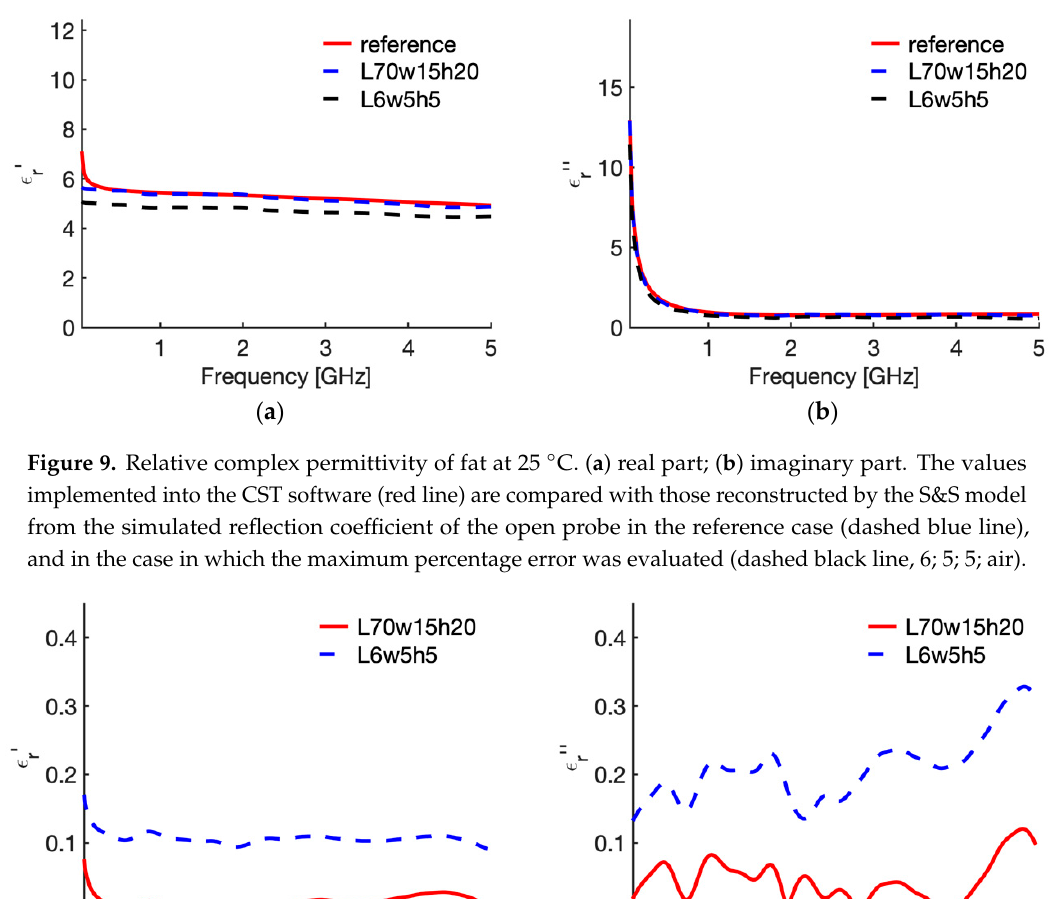
Figure 8. Percentage errors in the evaluation of the relative complex permittivity of liver at 25 °C through the reflection arrangement of the open probe technique. ( a ) real part; ( b ) imaginary part. The red curves give the error evaluated in the reference case, while the dashed blue line shows the error in the case where the maximum average error was calculated, i.e., case 10 in Table 2 (6; 5; 5; air).